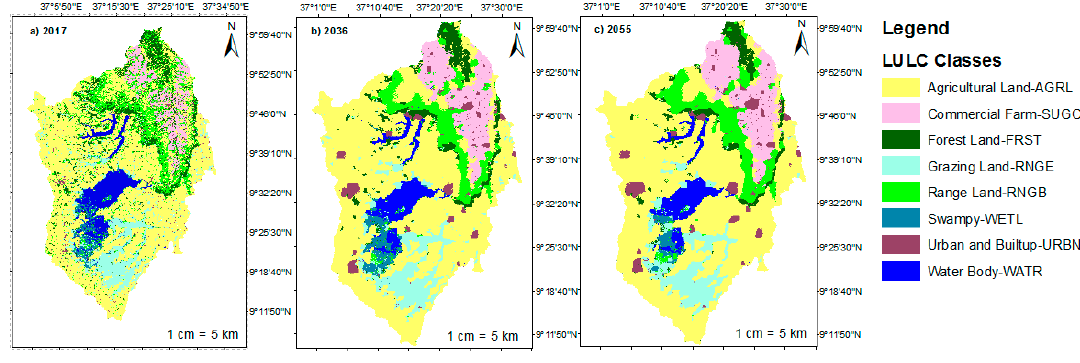
Figure 4. Land use/land cover maps and their SWAT code Figure 4. Land use / land cover maps and their SWAT